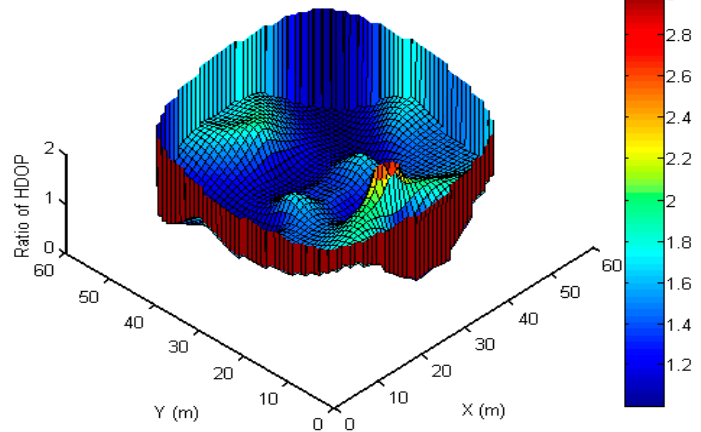
Figure 15. Ratio of HDOP between the Doppler positioning algorithm and Doppler differential positioning algorithm.